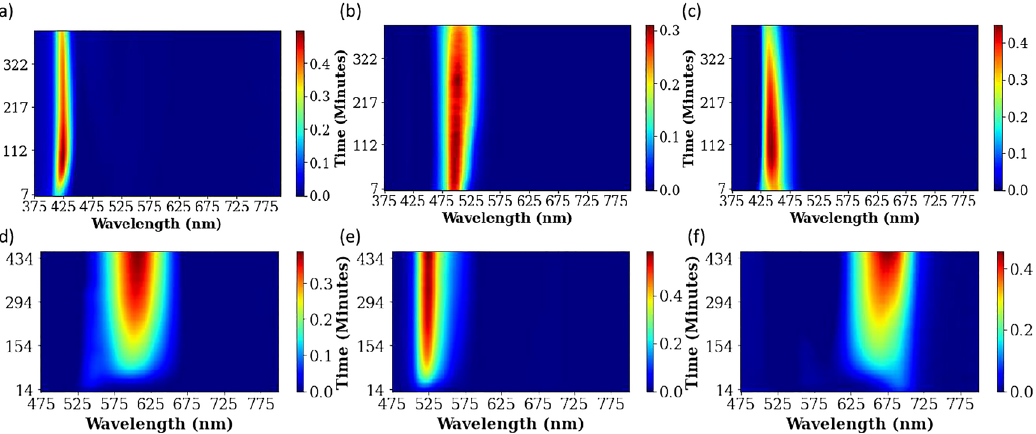
Figure3: TheNMFanalysisoftimedependentPLbehaviorinCsPb(Br x Cl 1 − x ) 3 ,CsPb(Br x I 1 − x ) 3 binaryQDssystems.Compositionaldependencies of the component intensities within the CsPbBr 3 and CsPbCl 3 binary system excited at 350 nm (Top: (a) – (c)). Compositional dependencies of the component intensities within the CsPbBr 3 and CsPbI 3 binary system excited at 450 nm (bottom: (d) –